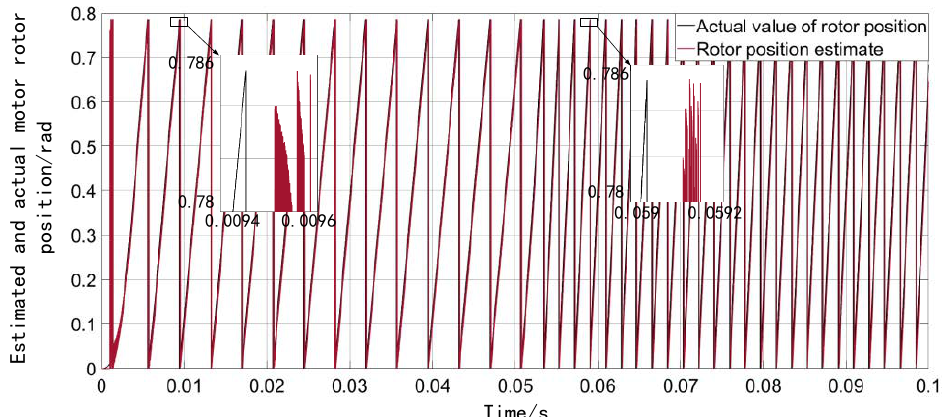
Figure 3. SMO Comparison diagram of the motor rotor position of the traditional SMO observer at high speed.